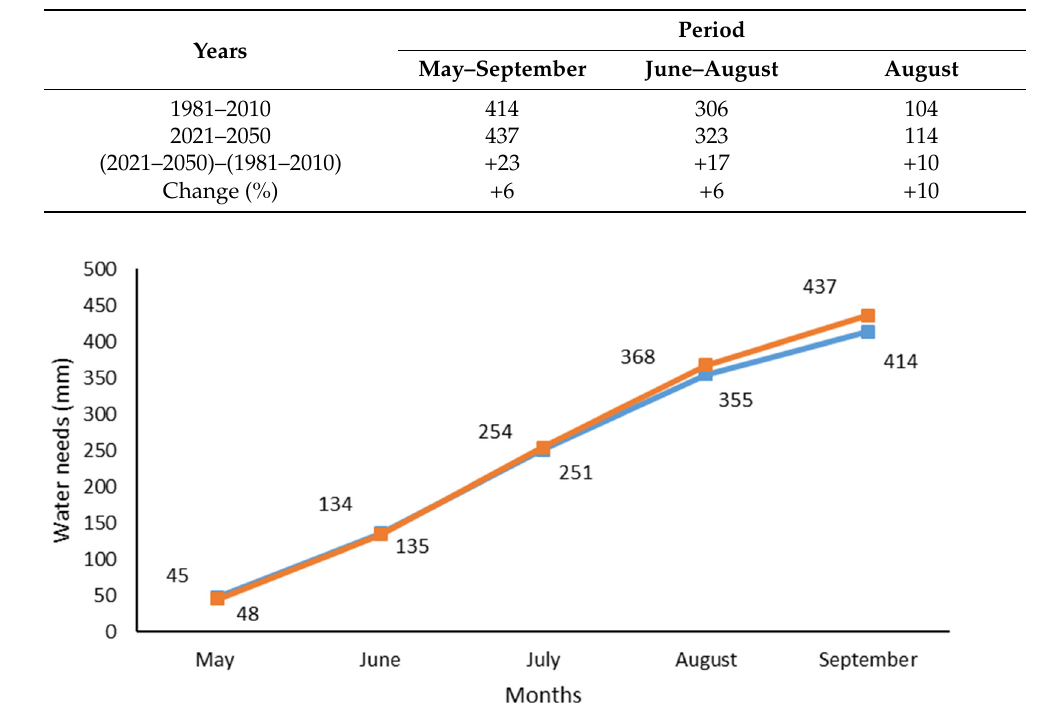
Figure 5. Monthly water needs of grapevines during the growing season in the reference years